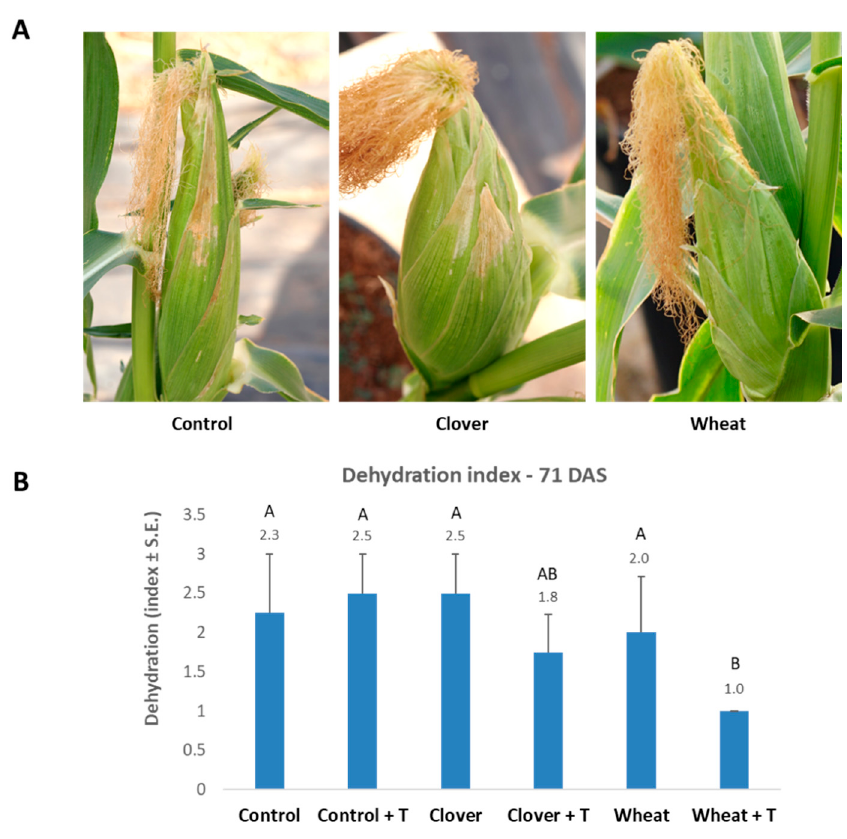
Figure 6. The 2020 commercial fields soil experiment—dehydration assessment on harvest day (71 DAS). The experiment is described in Figure 2. ( A ) Classification of the cobs’ spathes disease symptoms at the end of the 2020 experiment. Representative images of the treatments with varying degrees of late wilt symptoms. ( B ) Dehydration symptoms on the large bracts surrounding the cobs (the spathes) were estimated according to the following scale: 1—healthy with no signs of dehydration, 2—minor symptoms up to 20% of the cob surface, 3—moderate symptoms that cover 30–40% of the cob surface, and 4—diseased with 50% or more dehydrated cobs’ area. Values represent an average of 10–12 replications. Error bars indicate standard error. Statistically significant (one-way ANOVA, p < 0.05) differences between treatments at the same measures are indicated by different letters (A–B).